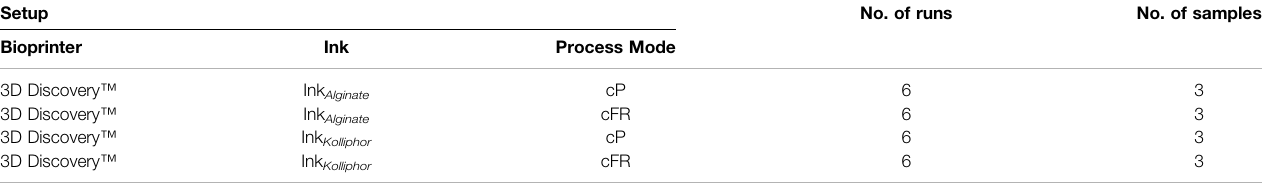
TABLE4| Summaryofallsetupsforthereproducibilityexperiments.Ink Alginate isanabbreviationforalltestedalginateconcentrationsof10,12,and15%(w/v)andInk Kolliphor for all tested Kolliphor concentrations of 25, 28, and 30% (w/v). Process mode means either constant pressure (cP) or constant fl ow rate (cFR). Setup